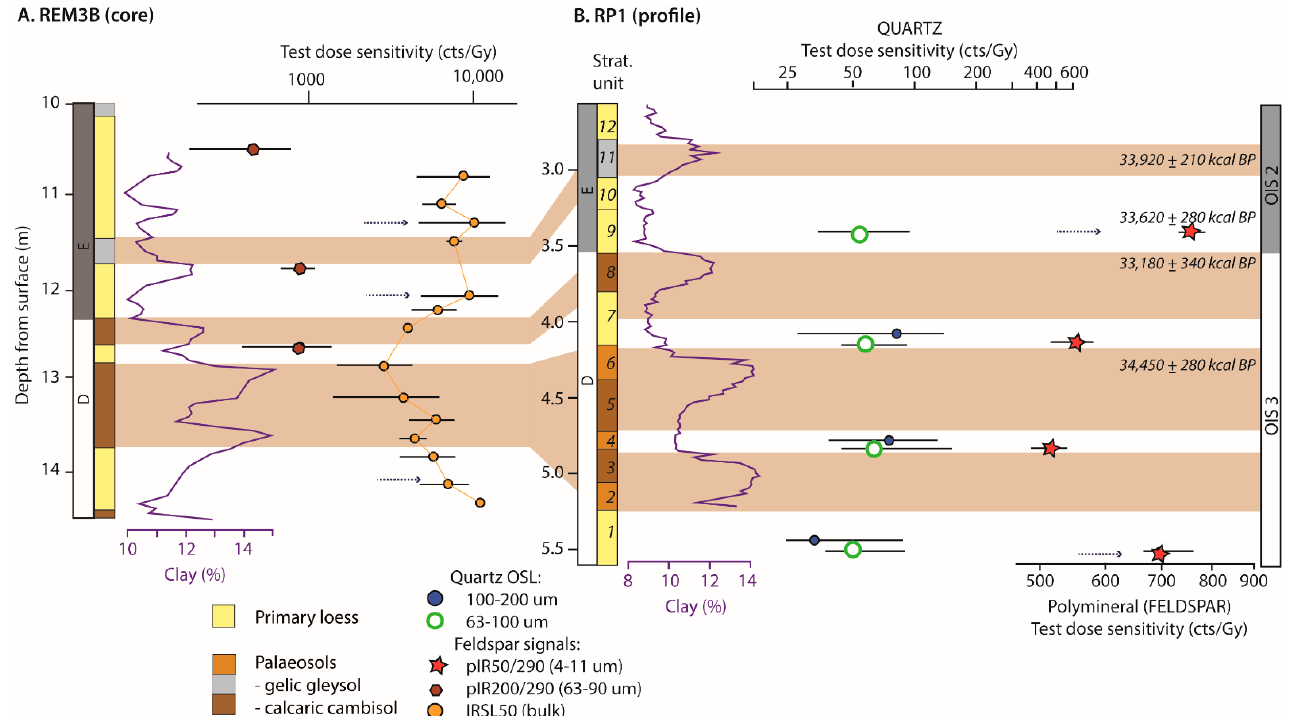
Figure 3. Comparison of luminescence test dose sensitivity (in cts/Gy) for the zone of temporal overlap between the REM3B core and RP1 profile. Stratigraphy and clay percentages, as well as the calibrated radiocarbon dates from earthworm calcite granules and accepted as final ages in [53], are shown for comparison with the sensitivity changes down sequence. Gelic gleysol and calcaric cambisol horizons are used for correlation across the figure. ( A ) Down core test dose sensitivity at REM3B measured for K-feldspar pIR 290 , and for bulk sediment using IR 50 . Error bars indicate standard deviations. ( B ) Down profile test dose sensitivity at RP1 based on two quartz size fractions as well as for K-feldspar pIR 290 . Since 14–24 aliquots were measured for each sample at RP1, sensitivity results are shown as box-plots with the median as a circle. Increased sensitivity in the feldspar measurements within loess horizons is highlighted by dark blue dashed arrows.